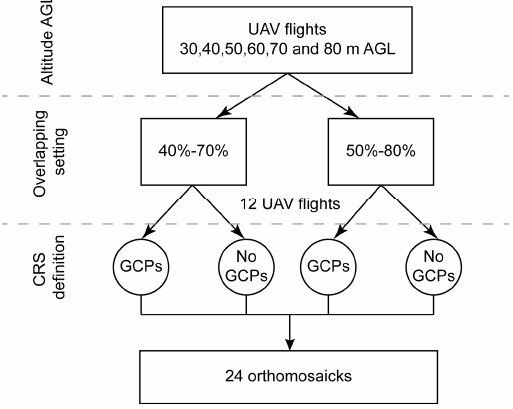
Figure 3. Scheme of unmanned aerial vehicle (UAV) flights and processing.